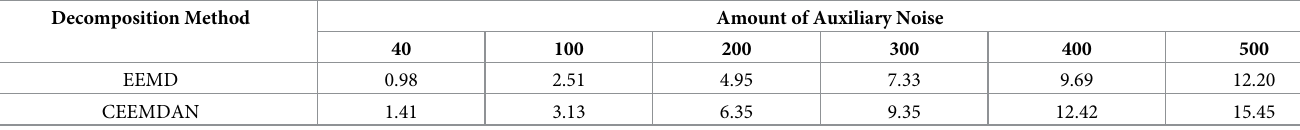
Table 1. Relative decomposition time compared with